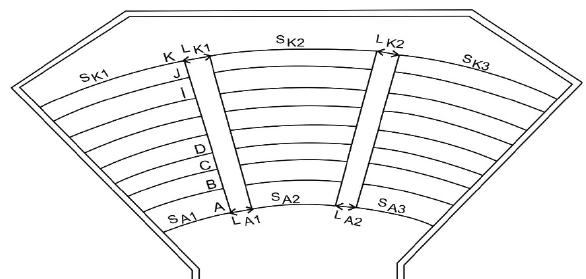
The bearing angles (e.g. for bearing ( OH the seat intermediate points in related curves from curve centre, considering the bearing value ( OH intersection point with the auditorium right side wall of related curve computed: